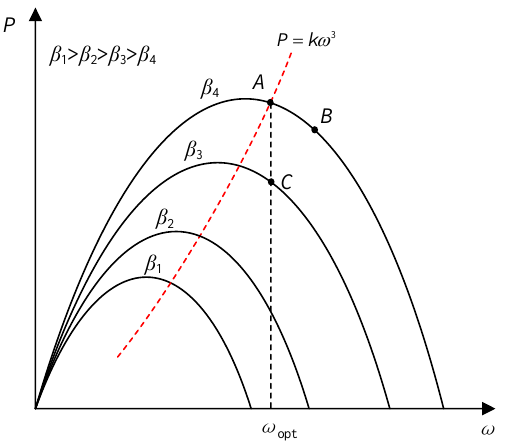
Figure 1. Wind power primary frequency regulation